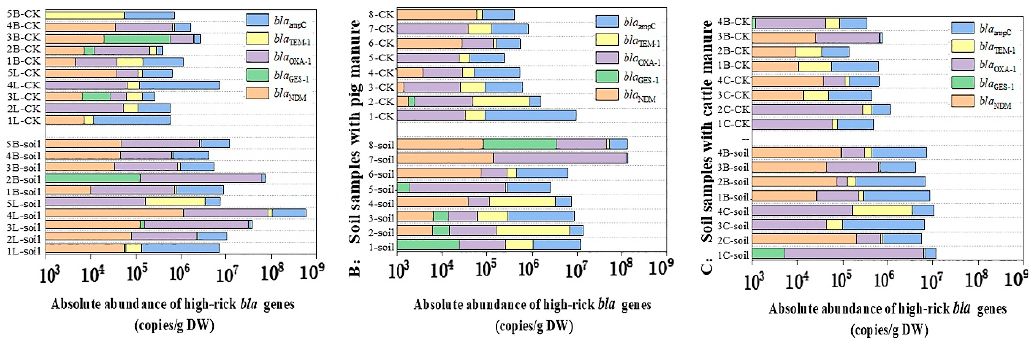
Figure 7. The absolute abundance of bla genes in soil samples applied with livestock manure of family farms.